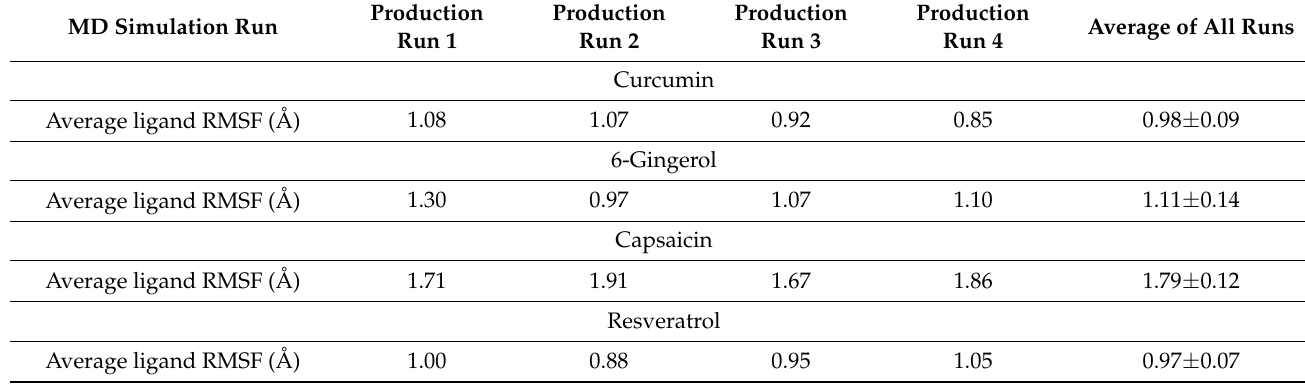
Table 4. Average RMSF values of ligand atomic positions throughout four independent 10 ns molecular dynamics simulation production runs of four investigated systems: curcumin in complex with PDE4D, 6-gingerol in complex with PDE4D, capsaicin in complex with PDE4D, and resveratrol in complex with